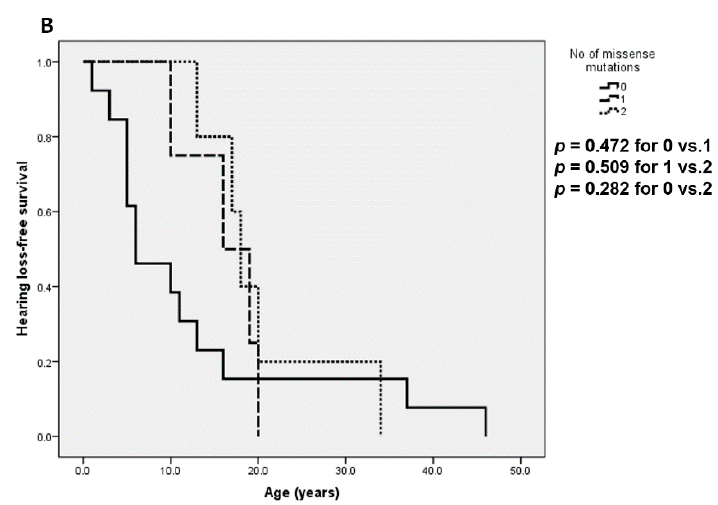
Figure 3. Hearing loss-free survival of ARAS patients according to ( A ) presence of missense mutation and ( B ) number of missense mutations.